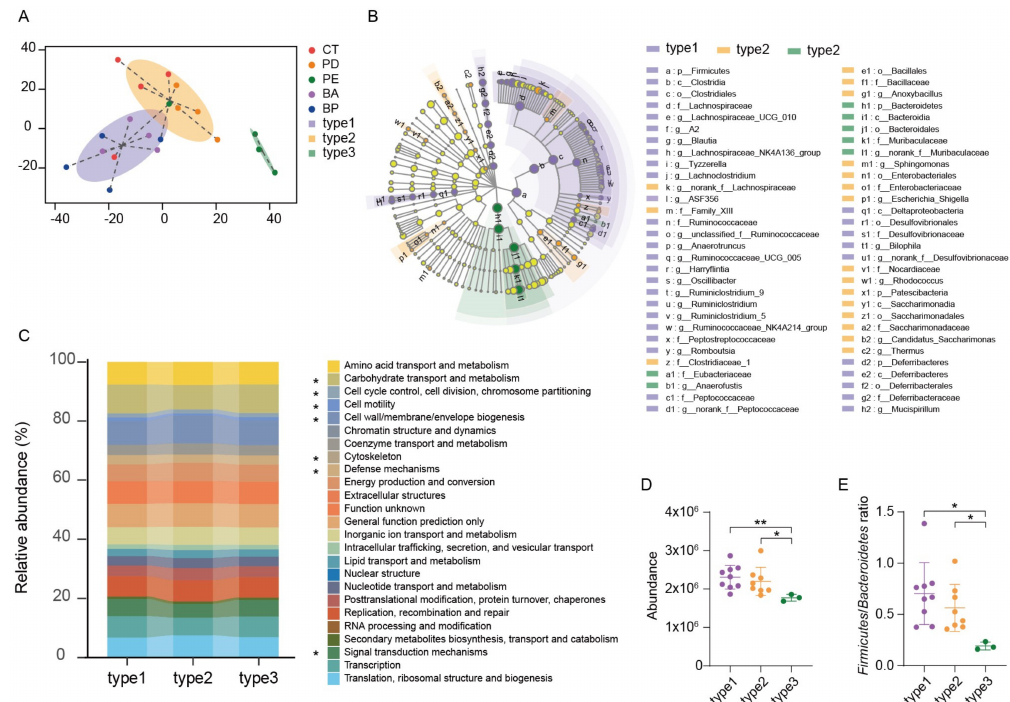
Figure 4. Enterotype analysis and functional di ff erences between di ff erent enterotypes. ( A ) Gut microbiome was clustered into three enterotypes at OTU-level using Jensen–Shannon distance, and the graphs for enterotype clusters indicate the first two principal coordinates. ( B ) Linear discriminant analysis e ff ect size (LEfSe) was used to di ff erentiate the three enterotypes. ( C ) PICRUSt prediction of functional profiling of the microbial communities from these three enterotypes based on the 16SrRNA gene sequences. ( D ) Di ff erence in the function of carbohydrate transport and metabolism and ( E ) The Firmicutes to Bacteroidetes ratio were tested using Student’s t -test, * p < 0.05, ** p <